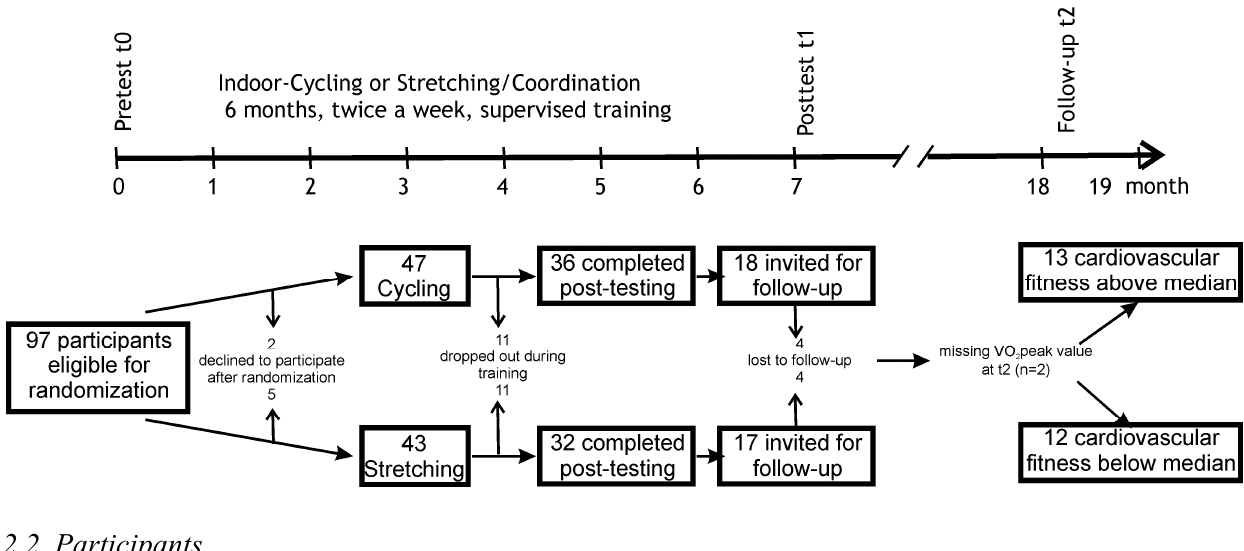
Figure 1. Study design and flow diagram showing the progress of participants through the phases of the study. Approximately half of the participants of the initial intervention study were assessed with magnetic resonance imaging (MRI) before and after the training. Only these participants were invited for a follow-up study one year after the end of the supervised